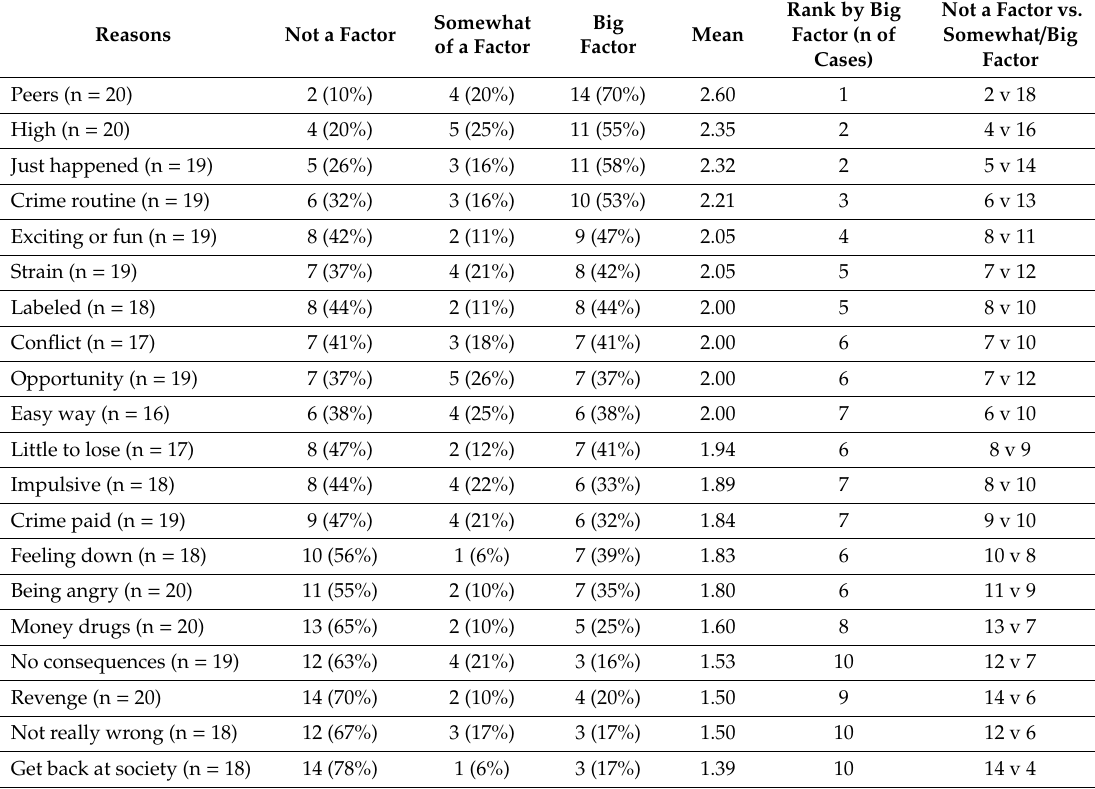
Table 3. Frequency, percent, mean and rank of the reasons for all 20 sample